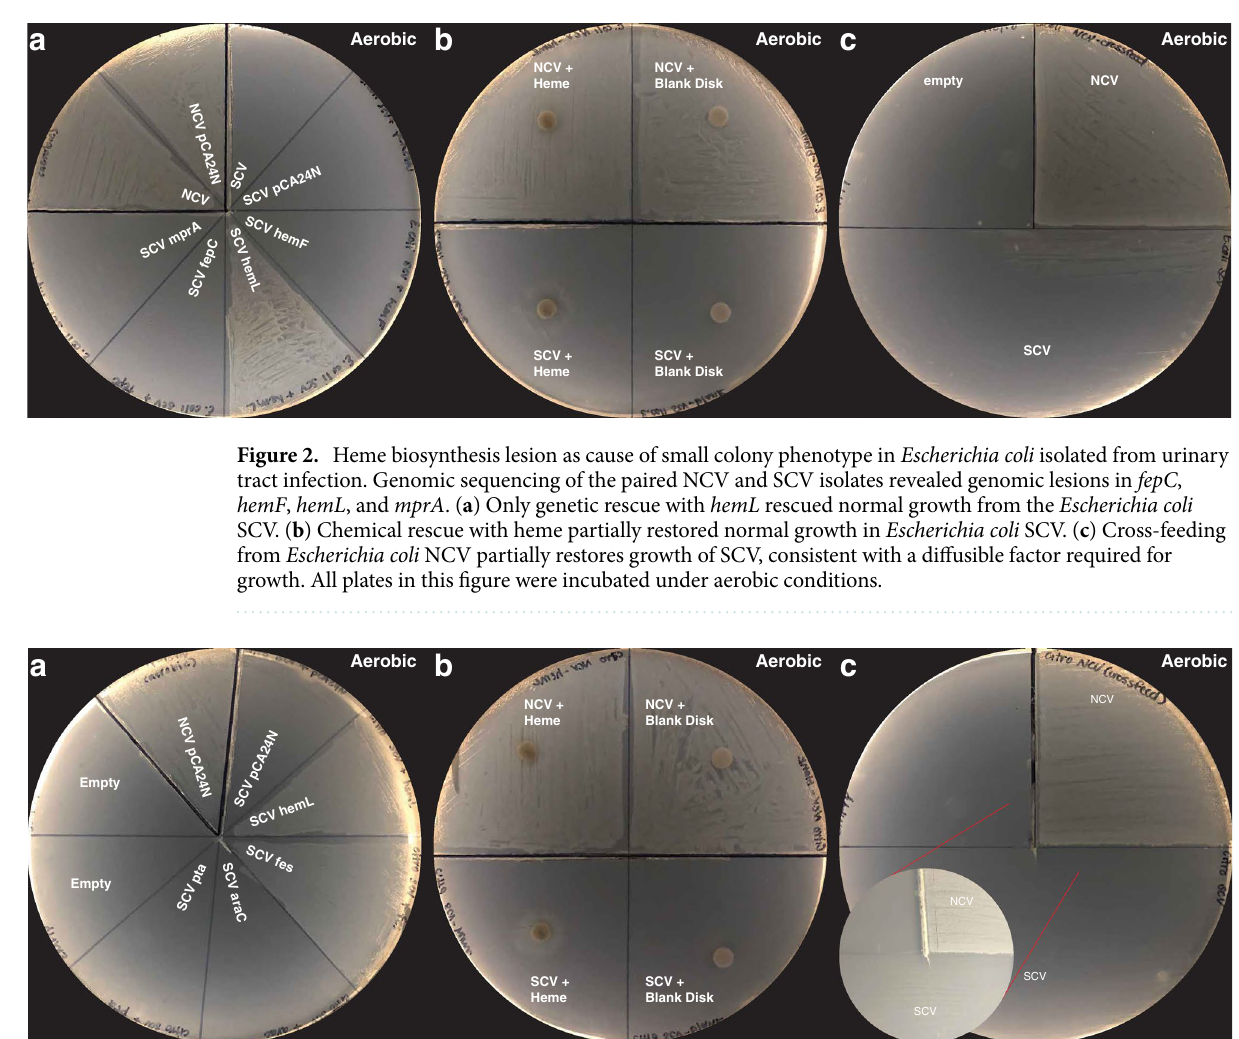
and C. freundii SCV isolates both displayed an extended lag phase and exhibited a lower OD 600 in the stationary phase compared to their NCV co-isolates (Fig. 5a,b). The E. hormaechei SCV did not displayed an extended lag phase compared its NCV co-isolate (Fig. 5c). However, the E. hormaechei SCV exited the exponential growth phase earlier than its NCV co-isolate and exhibited a lower OD 600 during the stationary phase. The growth kinetics of the E. coli SCV and C. freundii SCV isolates were completely rescued through overex- pression hemL (Fig. 5a,b). Genetic complementation with fes did not rescue the growth kinetic of the C. freundii isolate. The growth kinetics of the E. hormaechei SCV isolate were partially restored by complementation with